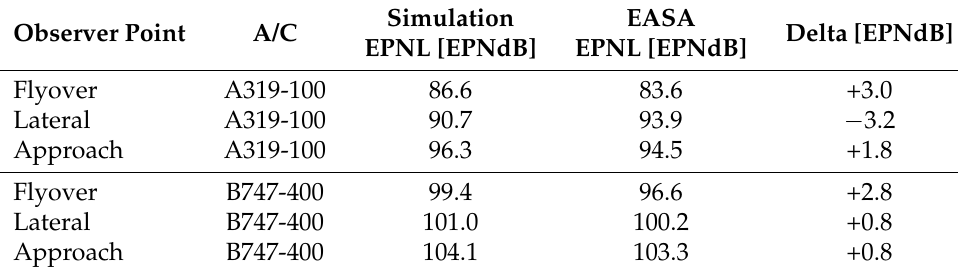
Table 3. Comparison of simulated and measured certification levels